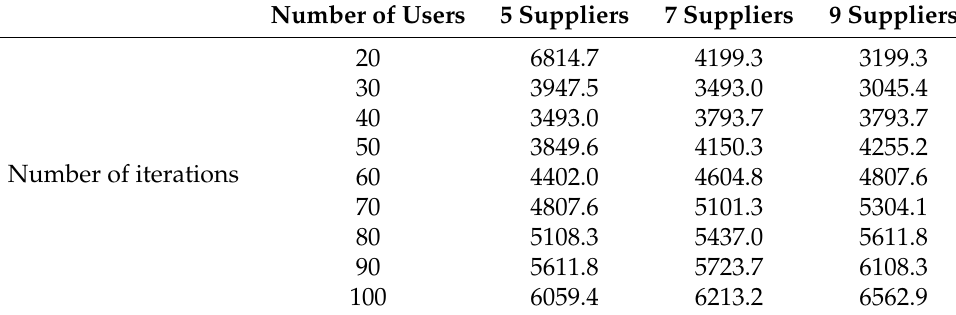
Table 2. Average time to convergence for different numbers of suppliers when ε = 10 − 3 . The chart shows that when the ratio of suppliers to users is too high or low, the algorithm will iterate many times to converge. For instance, nearly 7000 iterations are required for 9 suppliers and 20 users. When the number of users increases gradually, the number of users is approximately positively correlated with the average convergence